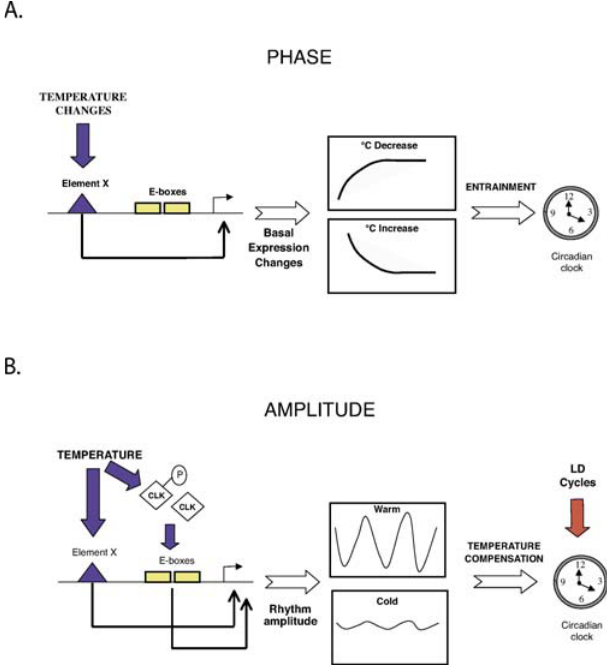
Figure 7. Model for Temperature Regulation of the per4 Promoter (A) Temperature steps entrain the phase of the clock by driving expression levels of per4 and other clock genes via a hypothetical enhancer element X. Temperature decreases result in expression increases, and vice versa. Although E-boxes ultimately mediate regulation of the per4 promoter by the entrained clock, they do not participate in the temperature-driven response. (B)Temperatureinfluencestheamplitudeofrhythmic per4 expressionthat has been entrained by LD cycles in two ways: (1) by determining the amplitude of E-box-directed rhythmic expression, via changes in CLK protein levels, phosphorylation, and E-box binding, and (2) by driving expression changes through element X (see panel A). The promoter integratesthesetworegulatorymechanisms.Thetemperature-dependent amplitude of E-box-directed rhythmic expression would be predicted to involve the core feedback loops of the clock itself and, according